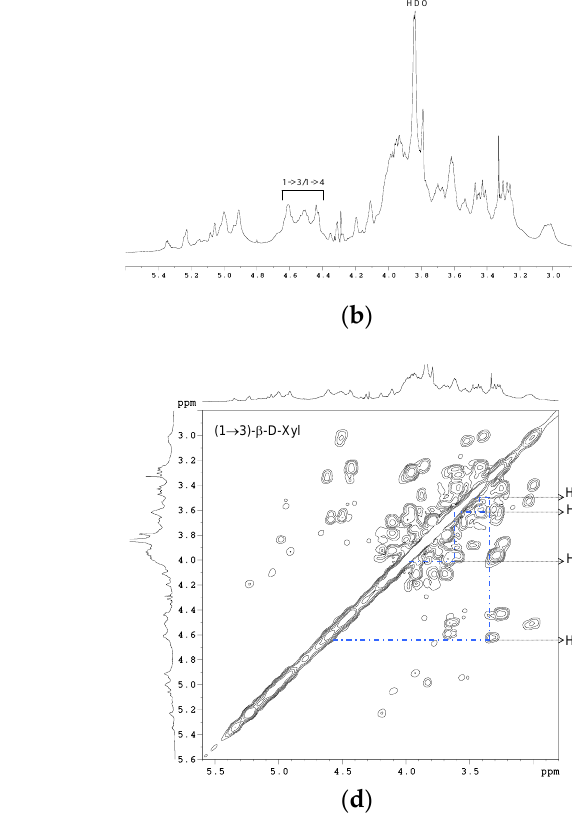
Figure 3. NMR spectra and COSY spectrum of purified Yanang gum. ( a ) 13 C-NMR spectra, ( b ) 1 H-NMR spectra. ( c ) COSY spectrum of Yanang gum, Dashed lines is the correlation of protons of 4- β -D-xylose . ( d ) COSY spectrum of Yanang gum, Dashed lines is the correlation of protons of 3- β -D-xylose .